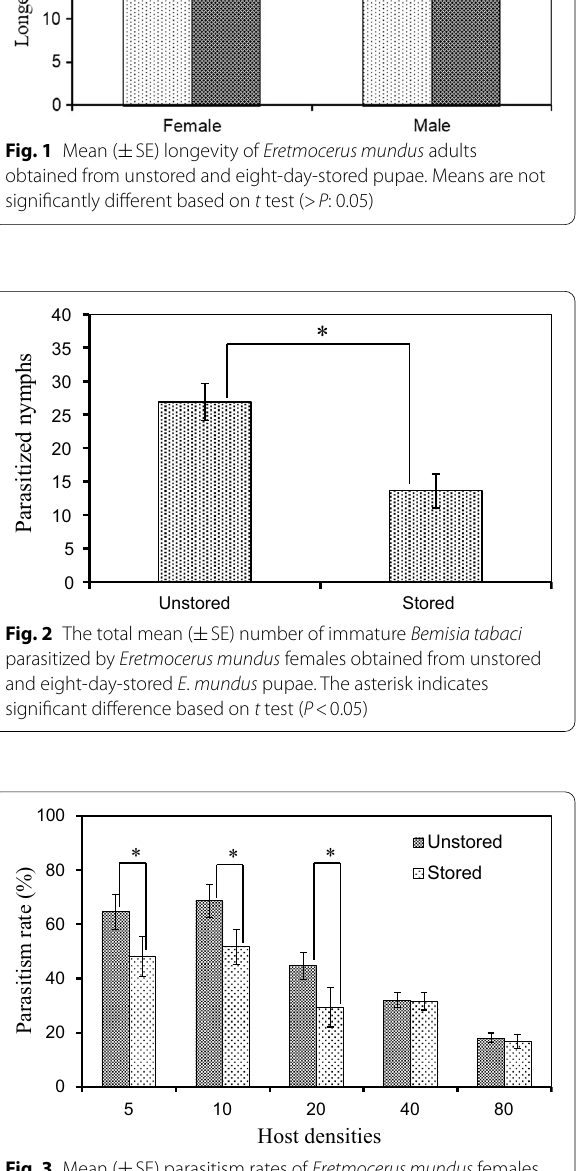
Fig. 3 Mean ( SE) parasitism rates of Eretmocerus mundus females ± obtained from unstored and eight-day-stored pupae to the different 2nd instar nymph densities of Bemisia tabaci . The asterisk indicates significant difference based on t test ( P < 0.05)